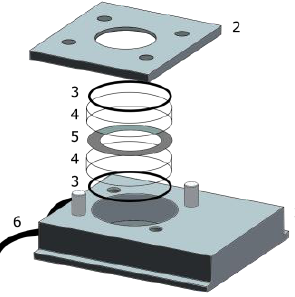
Figure 1. Calibration cell: between the body (1) and the top plate (2), O-seals (3), wedged CaF 2 windows (4) and a stainless steel spacer ring (5) are clamped to confine the thin liquid film within the spacer of a predefined height. The liquid temperature is set by heating cartridges (6) placed within the body [16].